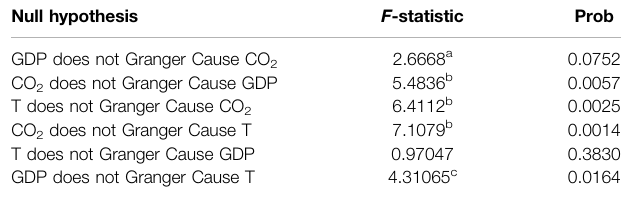
TABLE 3 | Short-run estimations.